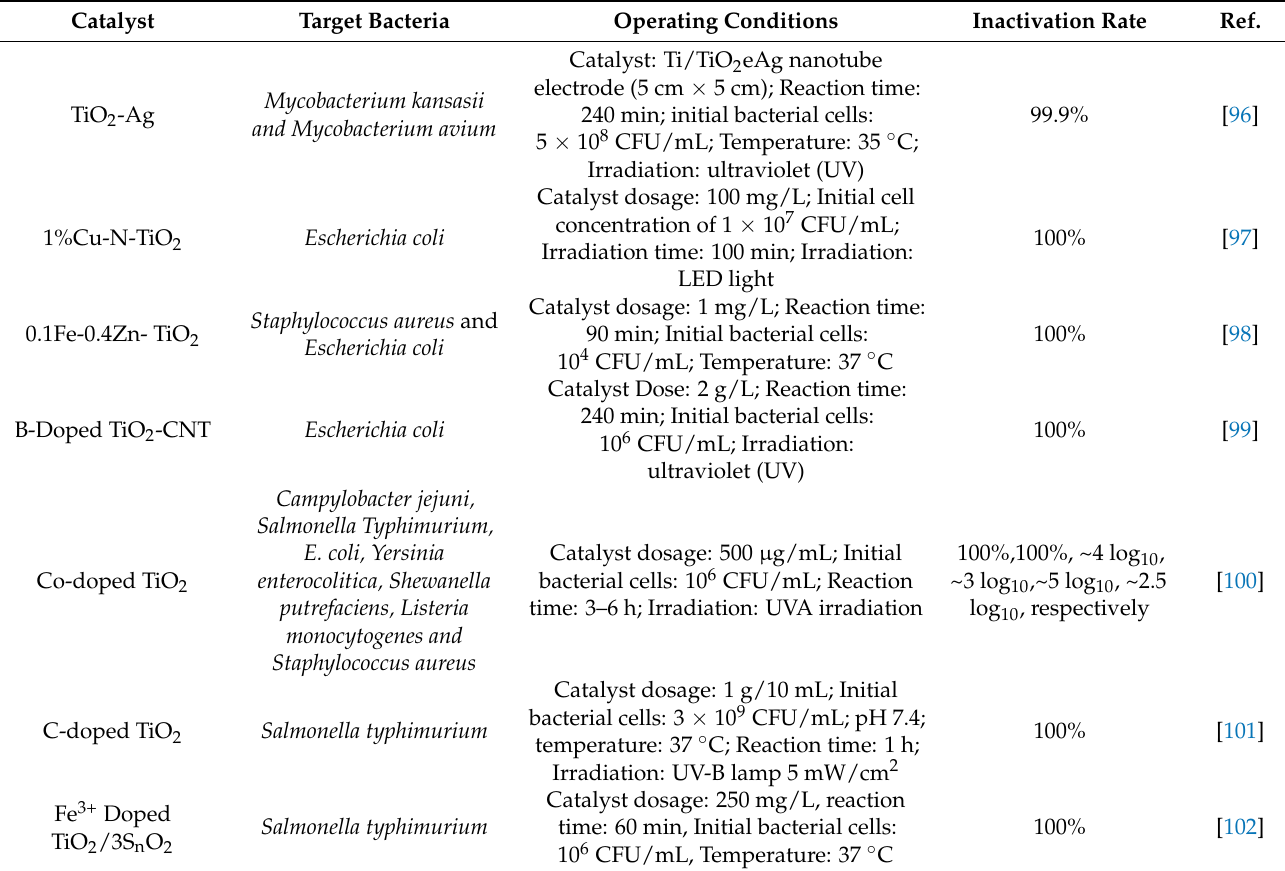
Table 3. Improved semiconductors for water